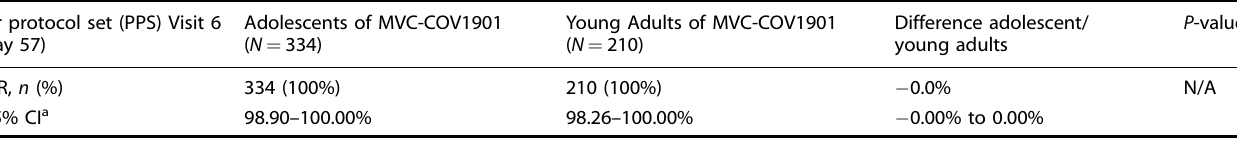
Table 4. Summary of non-inferiority of live SARS-CoV-2 neutralizing antibody seroconversion rate (SCR) between adolescents (12 – <18 years) and young adults (20 – 30 years) who received MVC-COV1901. Per protocol set (PPS) Visit 6 (Day